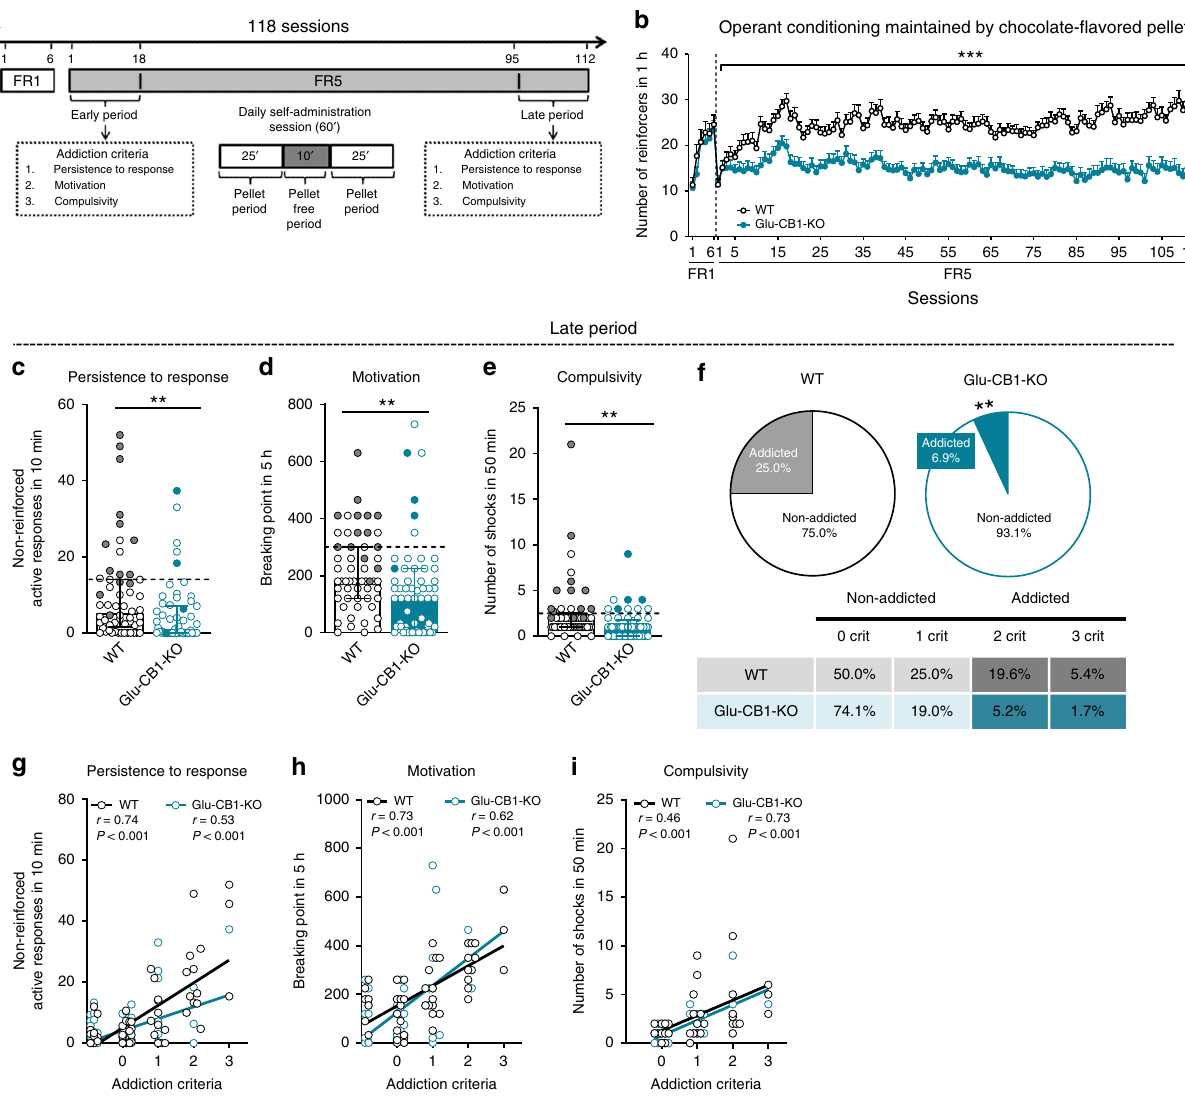
Fig. 1 Glu-CB1-KO mice display resilience to food addiction. a Timeline of the experimental sequence of the food addiction mouse model. b Reduced number of reinforcers during 1 h of operant training sessions maintained by chocolate- fl avored pellets in Glu-CB1-KO compared to WT mice (mean ± S.E.M, repeated measures ANOVA, genotype effect *** P < 0.001). c – e Glu-CB1-KO mice decreased response in the three addiction-like criteria tests (individual data with median and interquartile range, U Mann – Whitney, ** P < 0.01): c Persistence to response. d Motivation. e Compulsivity. The dashed horizontal line indicated the 75th percentile of distribution of WT mice, it is used as the threshold to consider a mouse positive for one criterion. Addicted mice in gray fi lled circles for WT and blue for Glu-CB1-KO mice. f Reduced percentage of mice categorized as addicted in Glu-CB1-KO compared to WT mice at the late period (chi-square, ** P < 0.01). g – i Pearson correlations between individual values of addiction-like criteria and g non-reinforced active responses in 10 min, h breaking point in 5 h and i number of shocks in 50 min ( n = 56 for WT mice and n = 58 for Glu-CB1-KO mice; see also Supplementary Figs. 1 and 2; statistical details are included in Supplementary Table